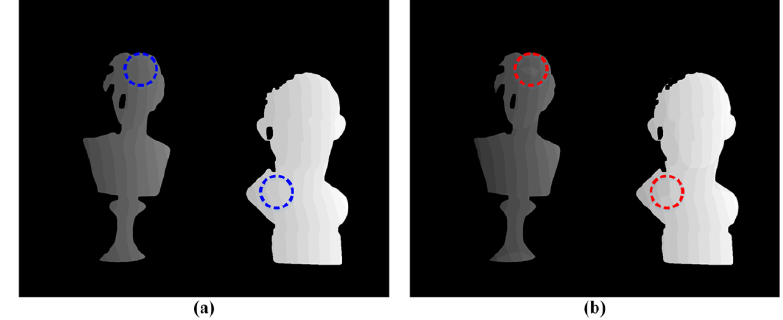
Figure 11. Fringe order maps. ( a ) The proposed method; ( b ) An’s method.